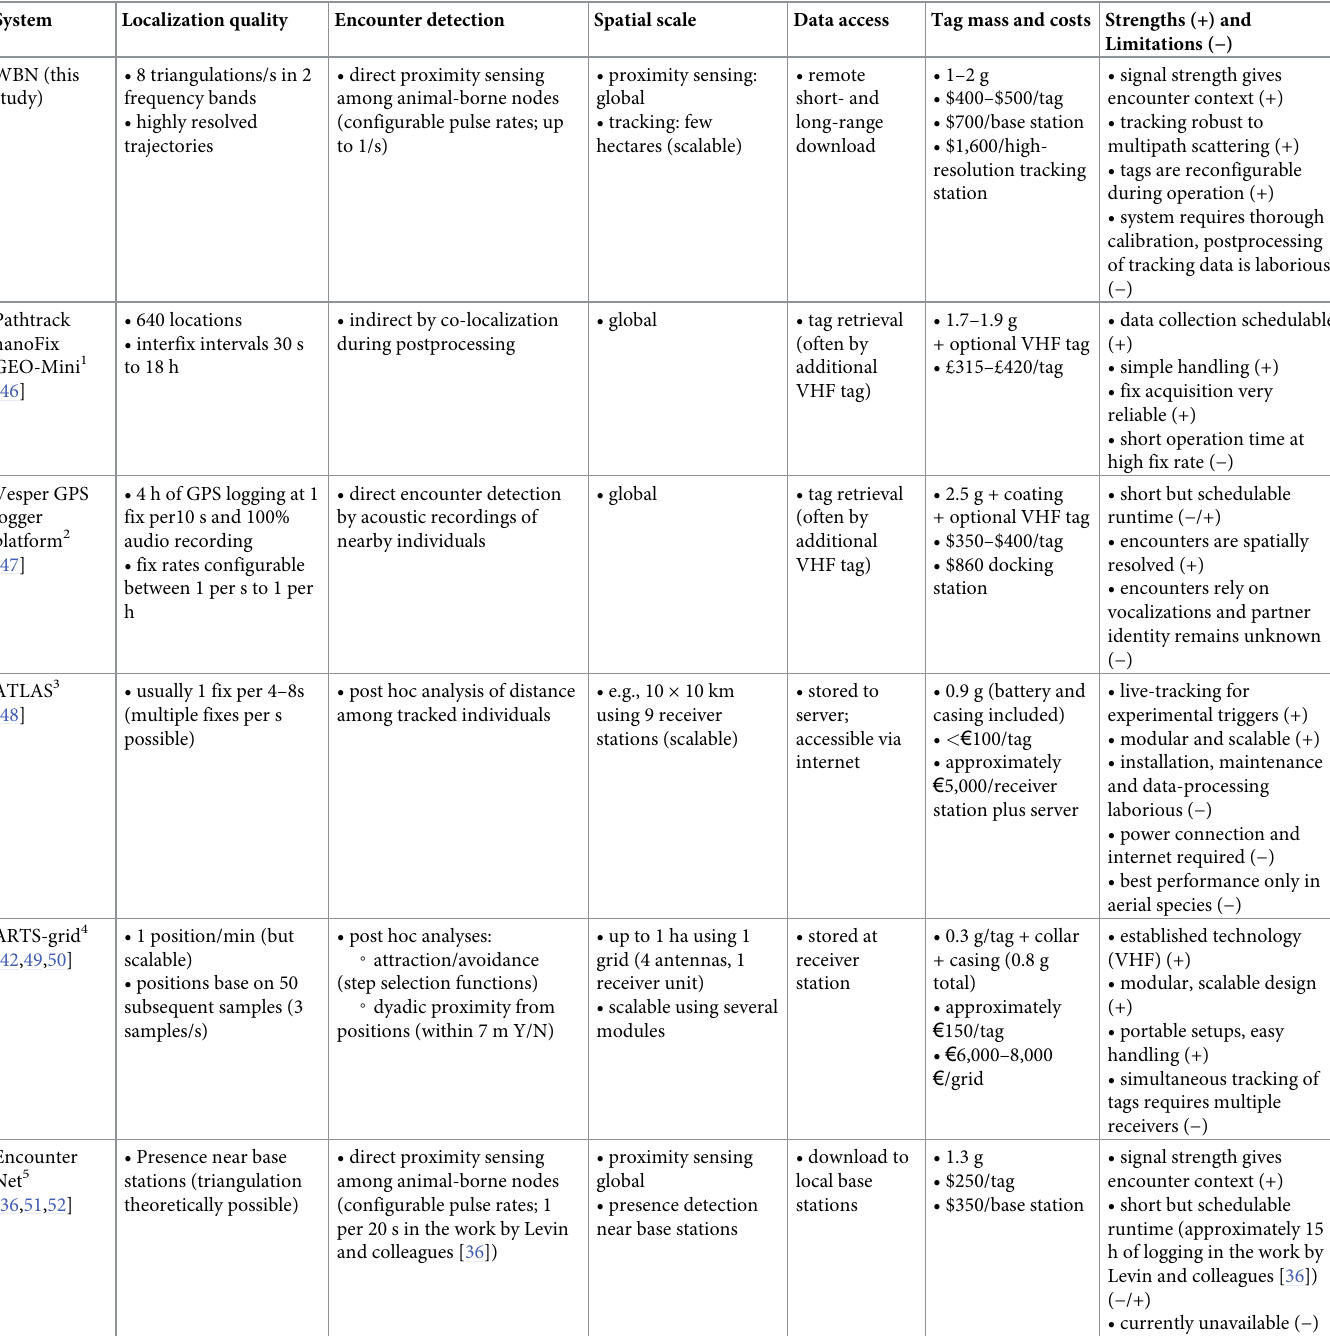
Table 2. Overview of tracking systems to track locations and/or encounters in small vertebrates (animal-borne tag � 2.5 g).